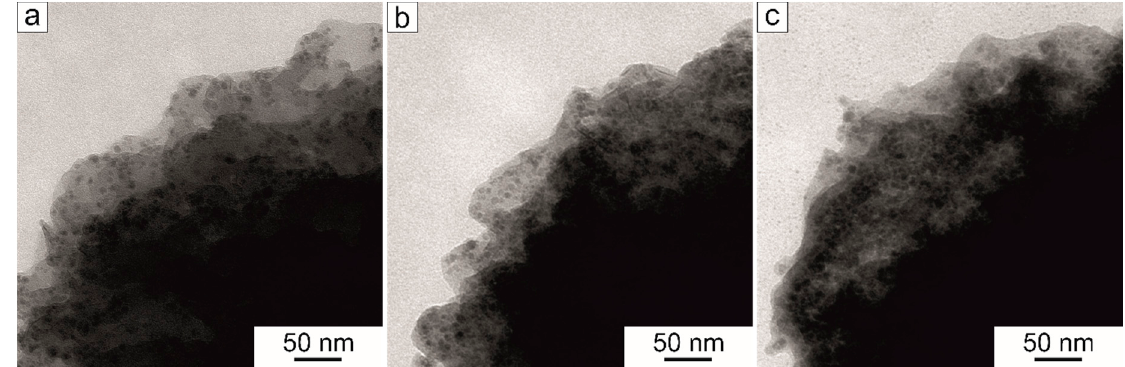
Figure 3. TEM images of ( a ) S, ( b ) LCS, and ( c ) HCS submicron core–shell.